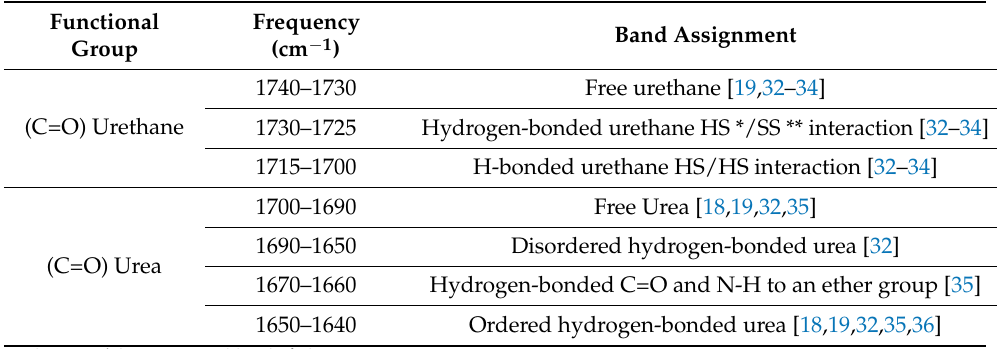
Figure 10. ( a ) Details of the monitored peaks of the amide I region (1740–1640 cm − 1 ) of PU foam obtained at 1000 rpm. ( b ) Example of deconvolution of the amide I region after 20 min via curve-fitting procedure. Table 6. Frequencies and band assignments of the carbonyl groups in the amide I region.